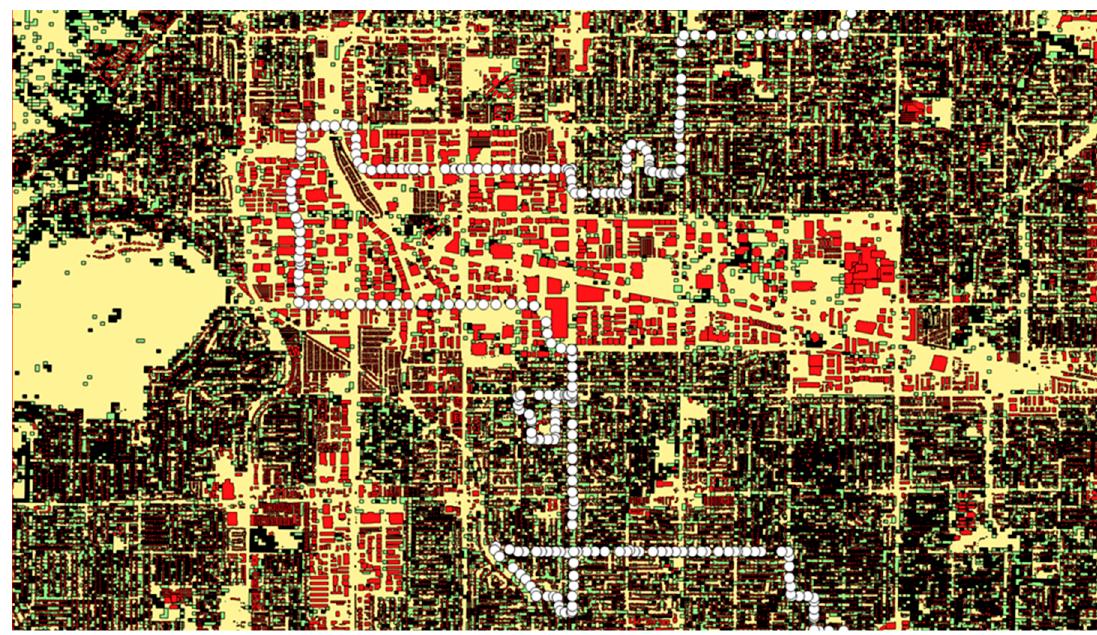
Figure 2. Detail from the San Fernando Valley domain in Figure 1, showing 30-m tree cover (yellow: <10%, light green: 10–20%, black: >20% cover), building-specific roof albedo (red: 0.05–0.25, orange: 0.25–0.50, light orange: 0.50–0.90), and a sample mobile transect segment (white dots).